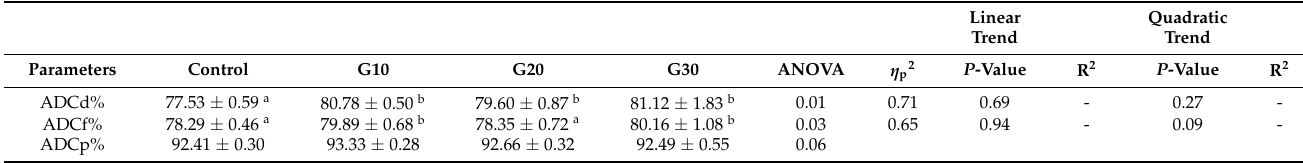
Table 4. Apparent digestibility coefficient for dry matter, fat, and protein in Eurasian perch provided feed supplemented with garlic powder.